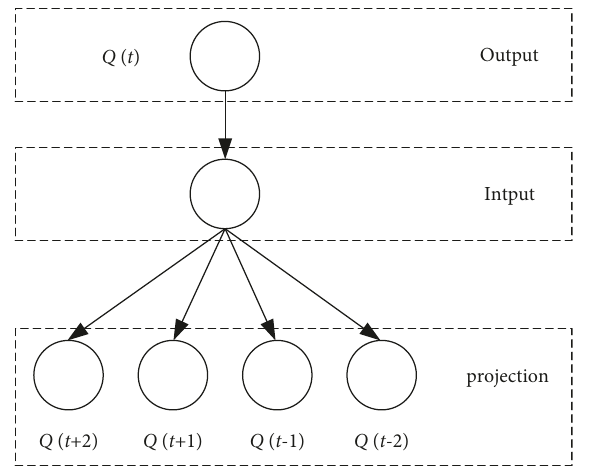
Figure 2: Basic architecture of Skip-gram